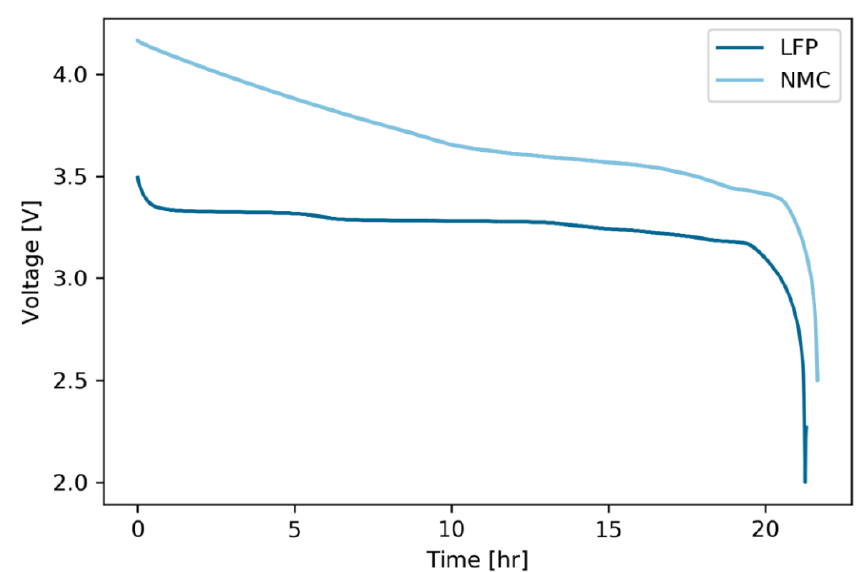
Figure 7. The decreasing voltage of two common LIB chemistries during discharge. The battery data were obtained from in [174] using low C-rate discharge (C/22), allowing the terminal voltage to be used to approximate the OCV.